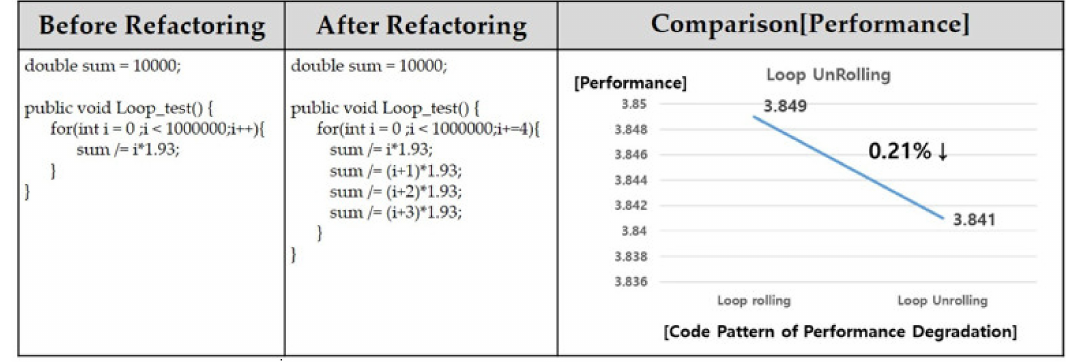
Figure 13. Before and after improving loop